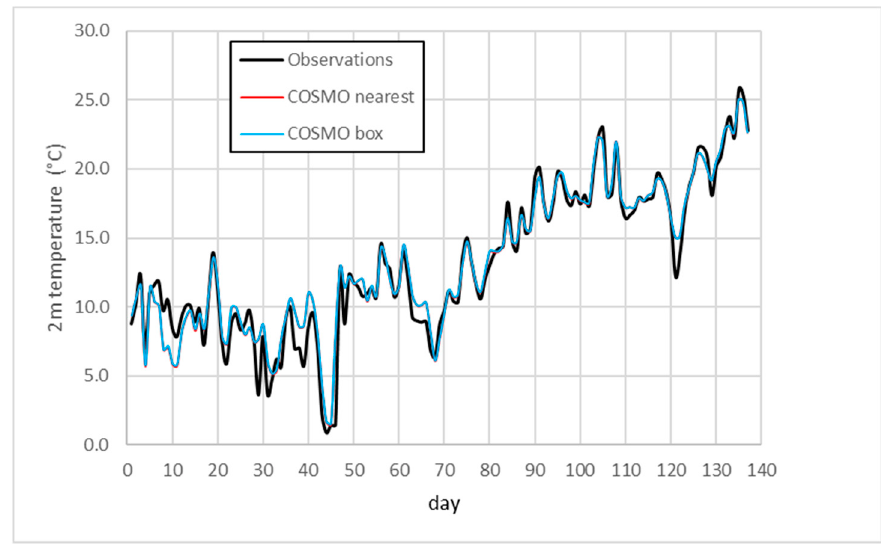
Figure 2. Time series of daily t2m (°C) at the CIRA site over the considered period: observational and model data for the nearest grid point and grid box.